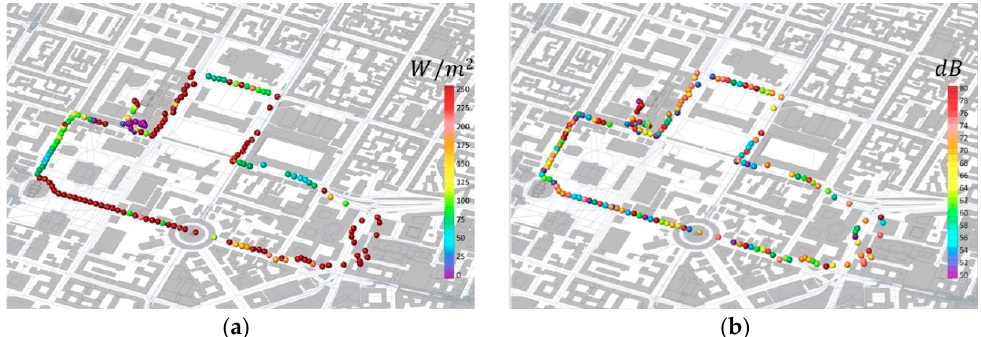
Figure 27. ( a ) Relative humidity (%); ( b ) wind speed (m/s).